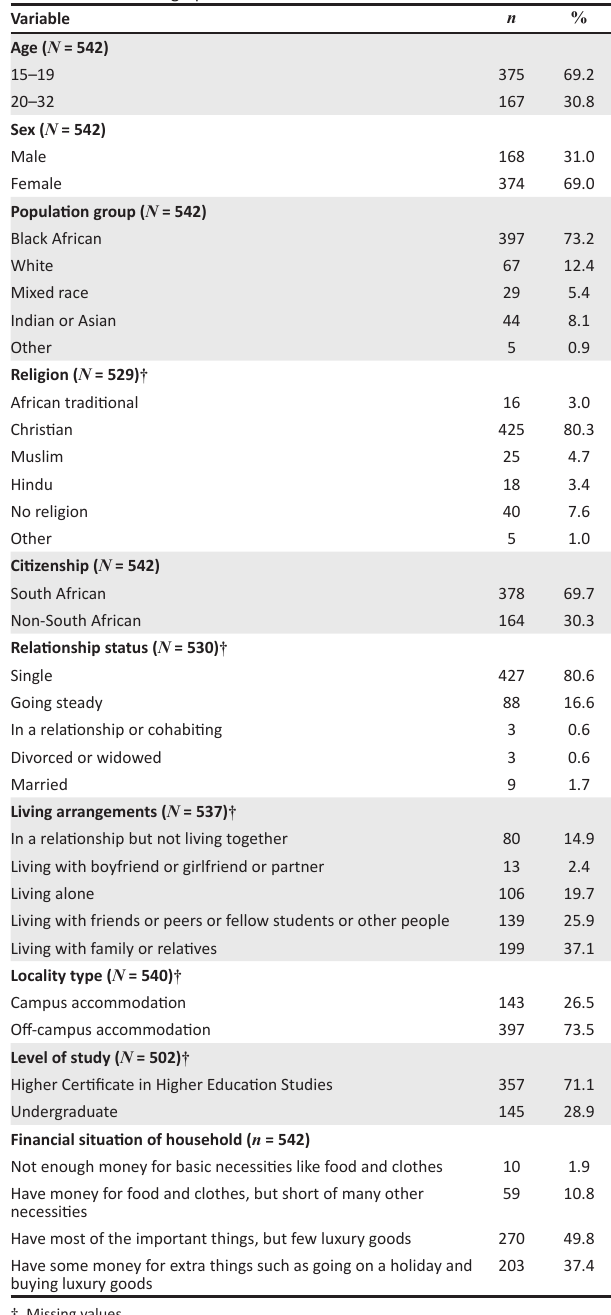
TABLE 1: Socio-demographic characteristics of